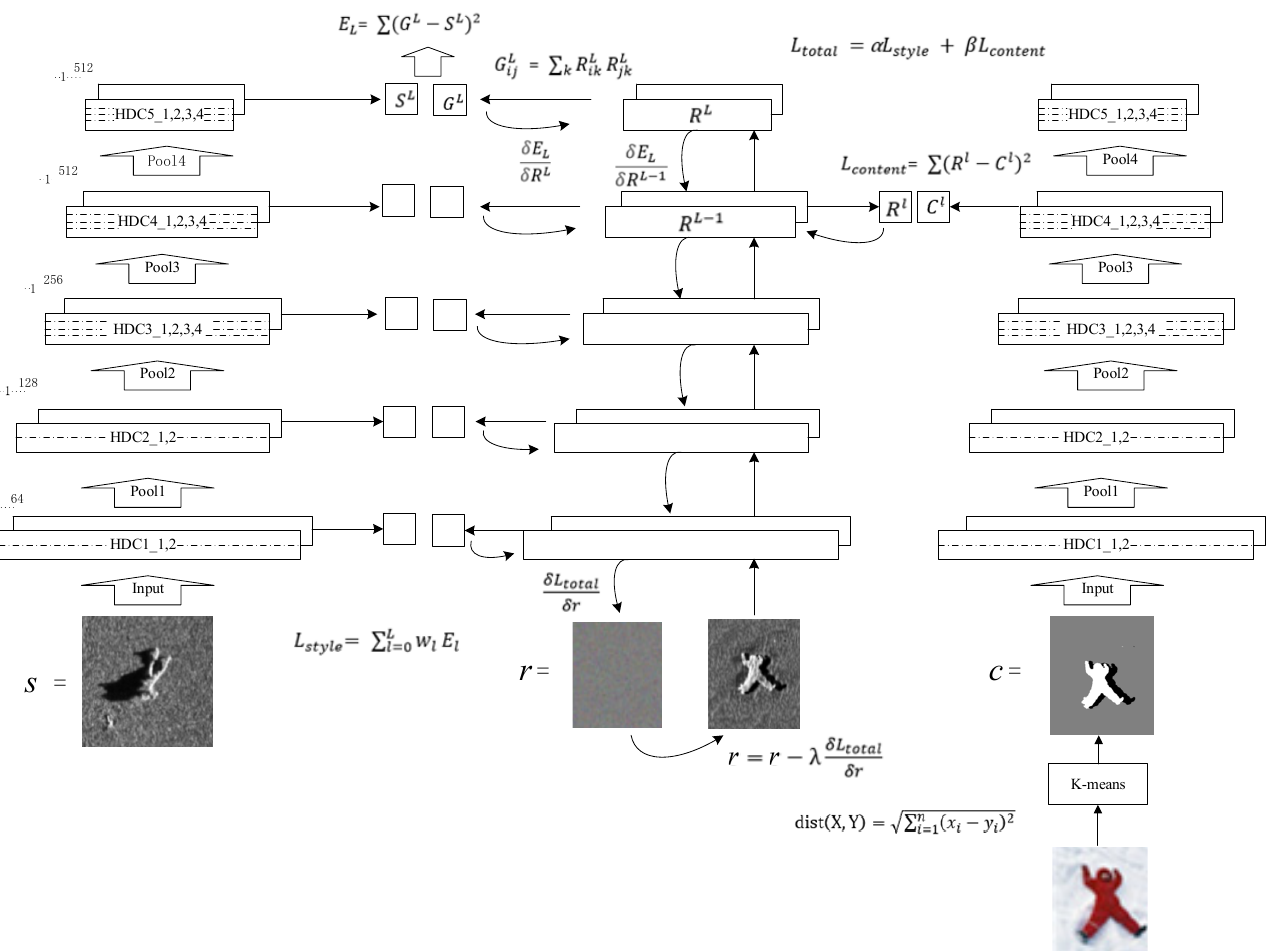
Figure 4. Improved style transfer network architecture in which the normal convolution is replaced by a hybrid dilated convolution in the network architecture, and a series of operations shown in Figure 3 are performed before inputting the image.